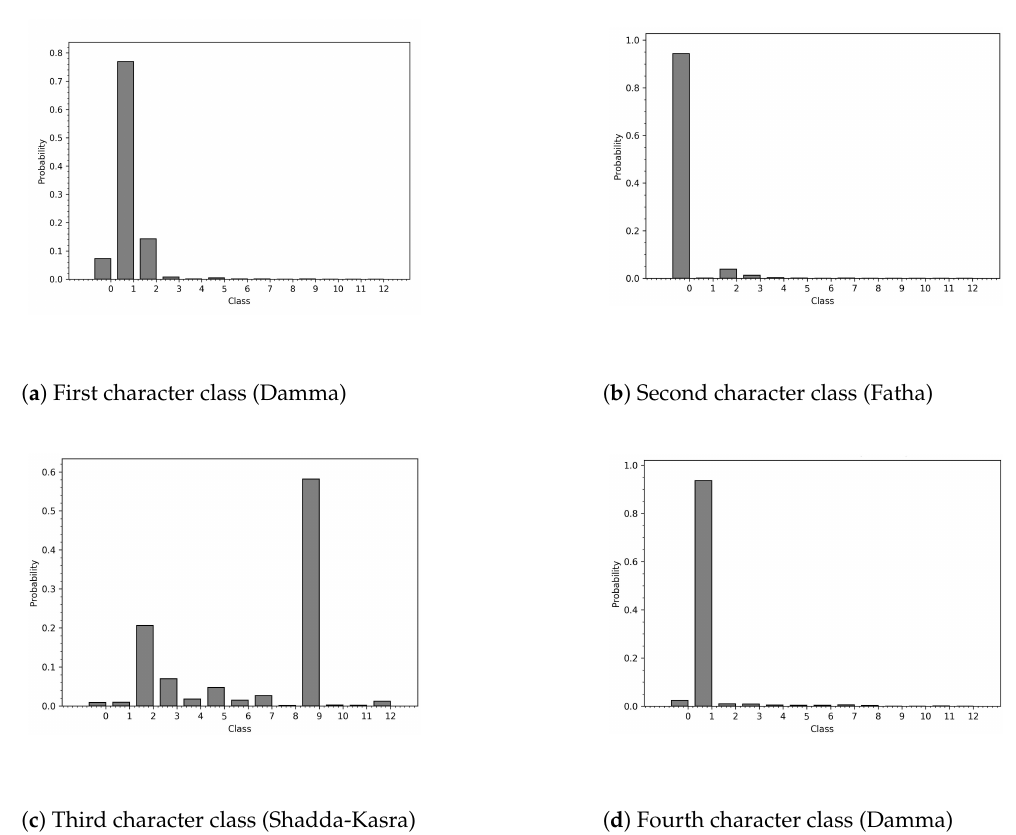
Figure 14. Probability distributions of class labels for the example word from the children’s stories